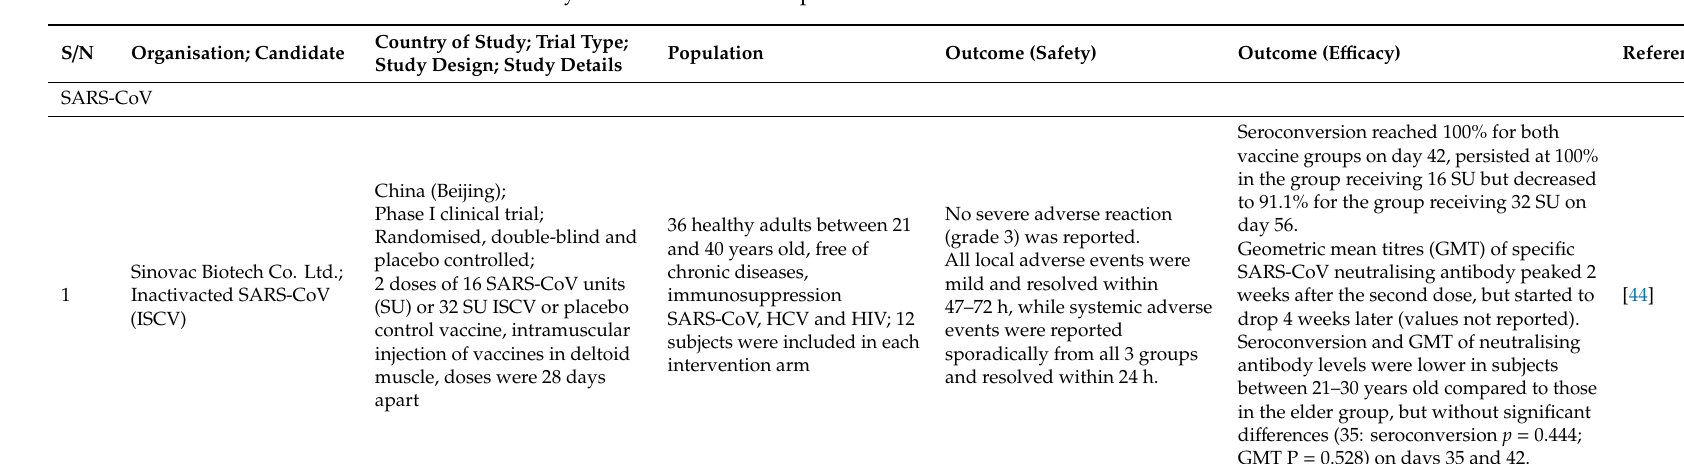
Table 4. Systematic search of completed vaccine trial of SARS-CoV and